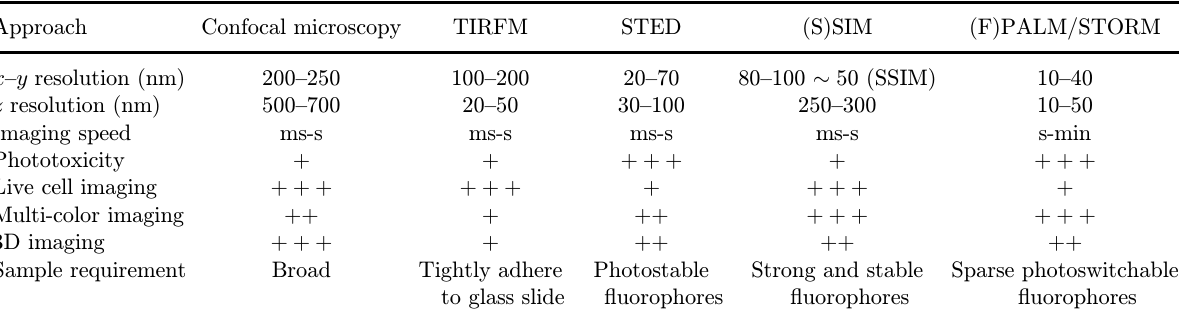
Table 1. Comparison of super-resolution